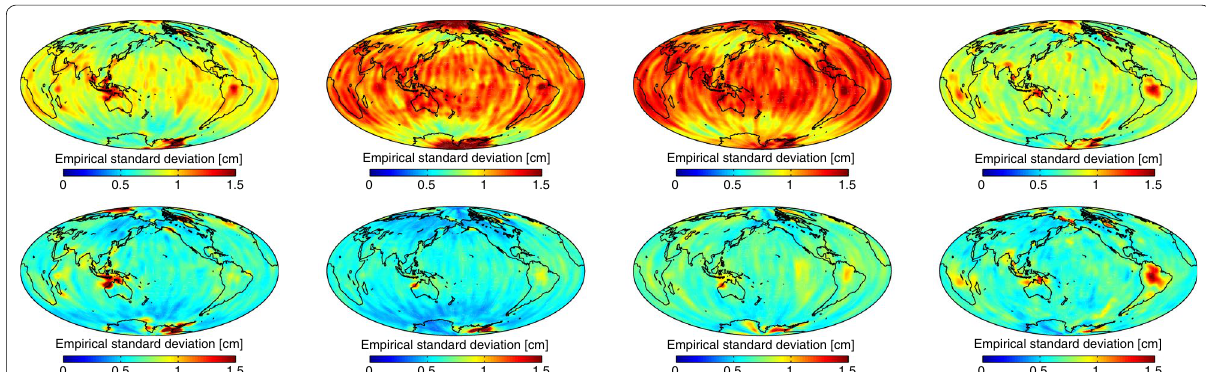
Fig. 3 Empirical standard deviations of GRACE RL05 and RL06 equivalent water height solutions (2004–2014): CSR RL05 DDK2, JPL RL05 DDK2, GFZ RL05 DDK2, ITSG-Grace2016 DDK2 (top, from left to right), CSR RL06 DDK2, JPL RL06 DDK2, GFZ RL06 DDK2, ITSG-Grace2018 DDK2 (bottom, from left to right)